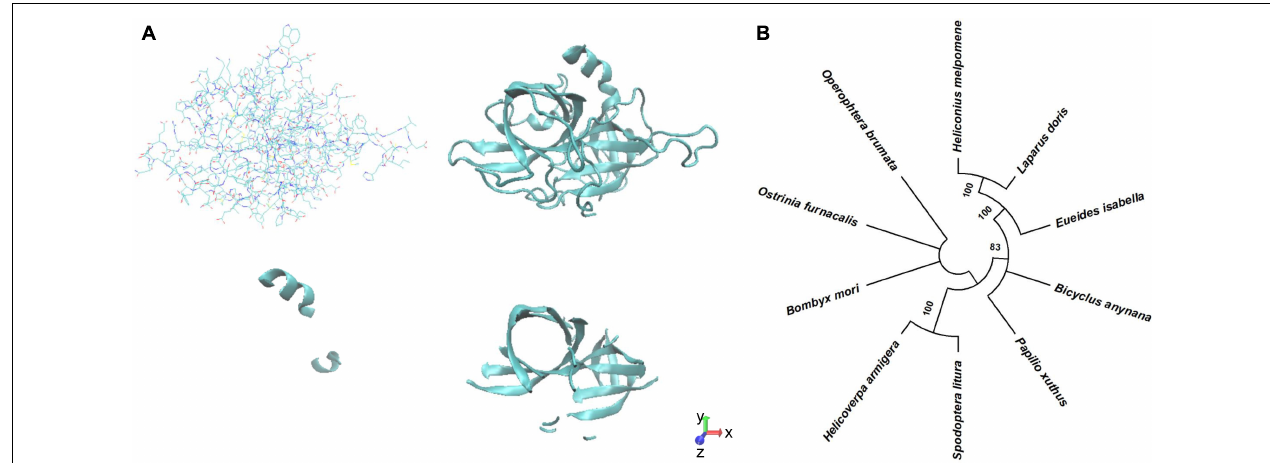
FIGURE 1 | Predicted structure Phylogenetic analysis of BmSer1 protein. (A) Predicted structure in licorice representation and ribbon diagram. (B) Phylogenetic tree. Protein sequences from B. mori (NP_001153674.1), O. furnacalis (XP_028171578.1), P. xuthus (XP_013174764.1), S. litura (XP_022835461.1), H. armigera (XP_021184761.1), O. brumata (KOB66629.1), H. melpomene (ADJ58567.1), E. isabella (AEU11620.1), B. anynana (XP_023944151.1), and L. doris (AEU11625.1). The tree is drawn to scale, with branch lengths in the same units as those of the evolutionary distances used to infer the phylogenetic